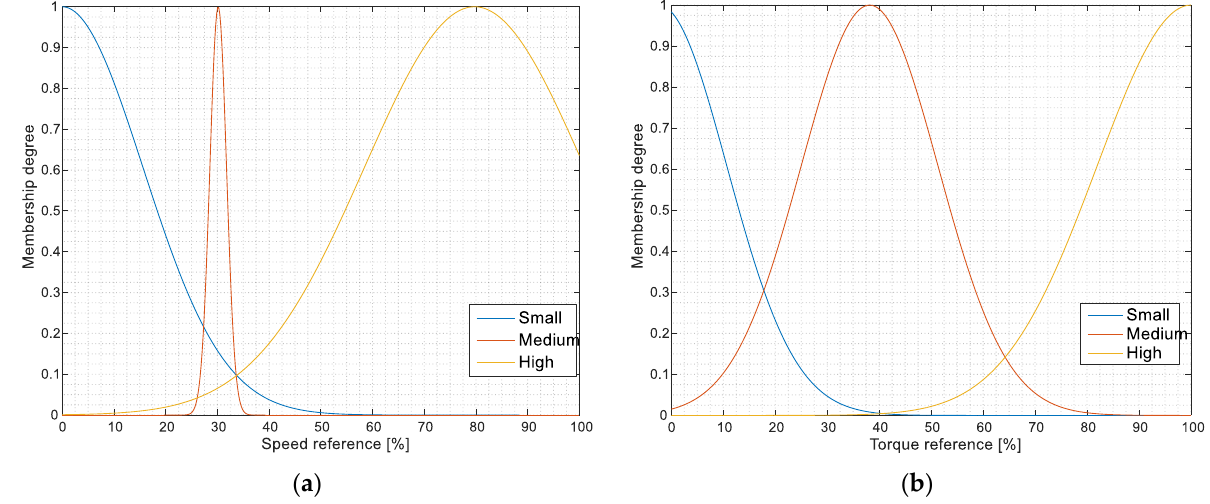
Figure 6. ( a ) Speed reference membership function; ( b ) Torque reference membership function.